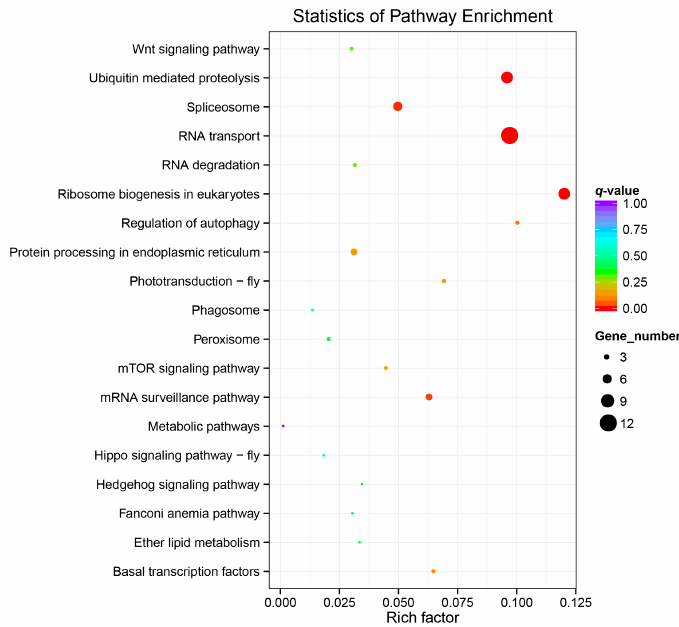
Figure 7. Scatterplot of Kyoto Encyclopedia of Genes and Genomes (KEGG) pathway enrichment analysis. The “Rich factor” is the ratio of the BmWD40 gene number to the total annotated gene number in a certain pathway. The size and color of the dots represent the range of the gene number and the q -value, respectively. Details are provided in Supplementary File Table S4.